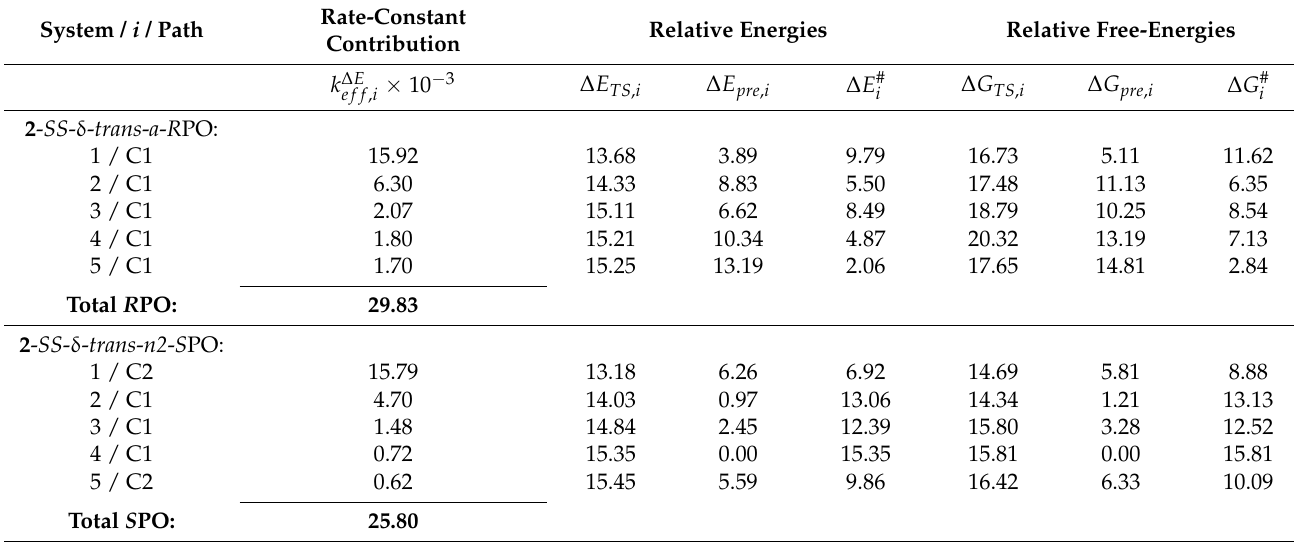
Table 4. Summary of the most important epoxide-opening reaction pathways for 2 - SS - δ - trans - a - R PO and 2 - SS - δ - trans - n2 - S PO systems: the contribution to the effective rate constant ( k ∆ E , in s − 1 ), relative electronic energies and free energies ef f , i (in kcal/mol) of the transition states ( ∆ E TS , i and ∆ G TS , i ) and prereactive epoxide complexes ( ∆ E pre , i and ∆ G pre , i ), and the corresponding activation barriers ( ∆ E # and ∆ G # ). The relative electronic energies/free energies of R PO/ S PO complexes i i were calculated with respect to the minimum-energy R PO/ S PO structure. The activation barriers were expressed with respect to the corresponding prereactive